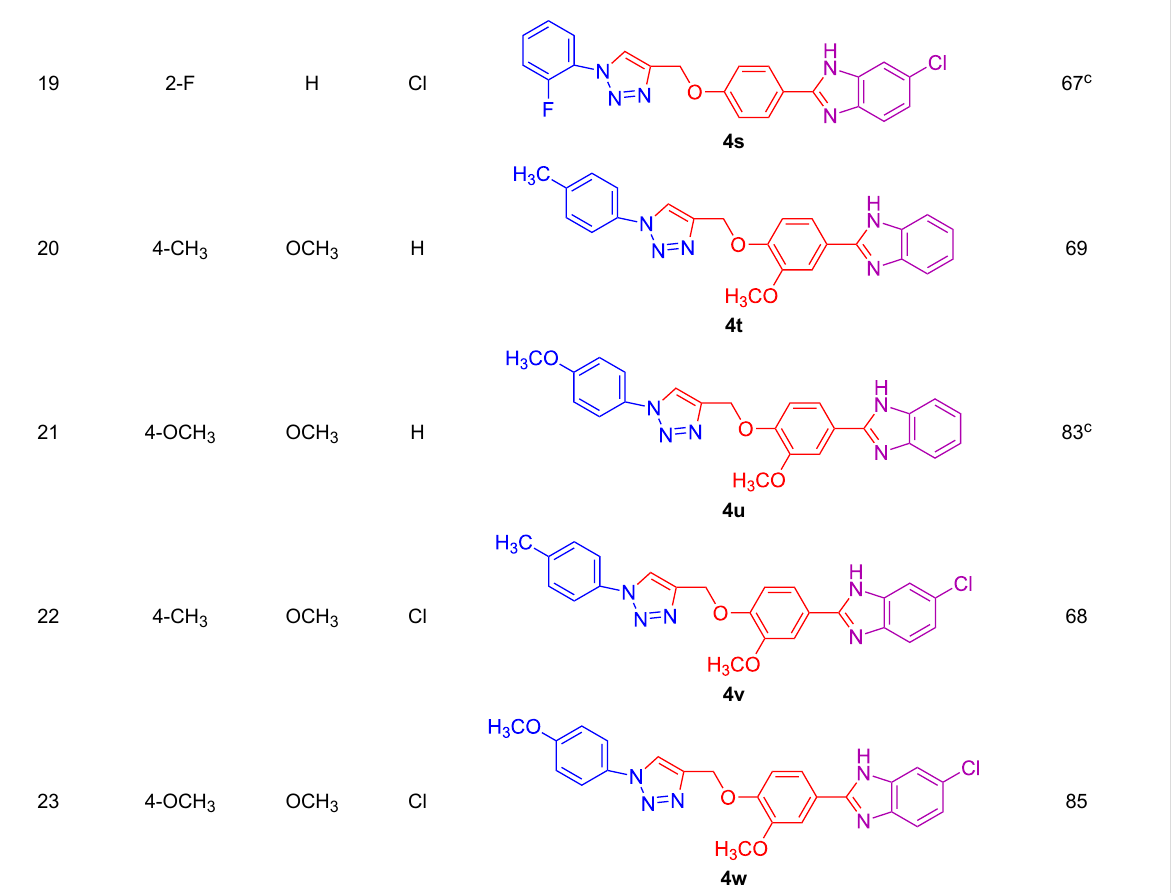
Table 2: Scope and limitations of the protocol employing different 4-(prop-2-yn-1-yloxy)benzaldehydes ( 2 ), phenylazides ( 1 ) and 1,2-diaminoben- zenes ( 3 ) a .